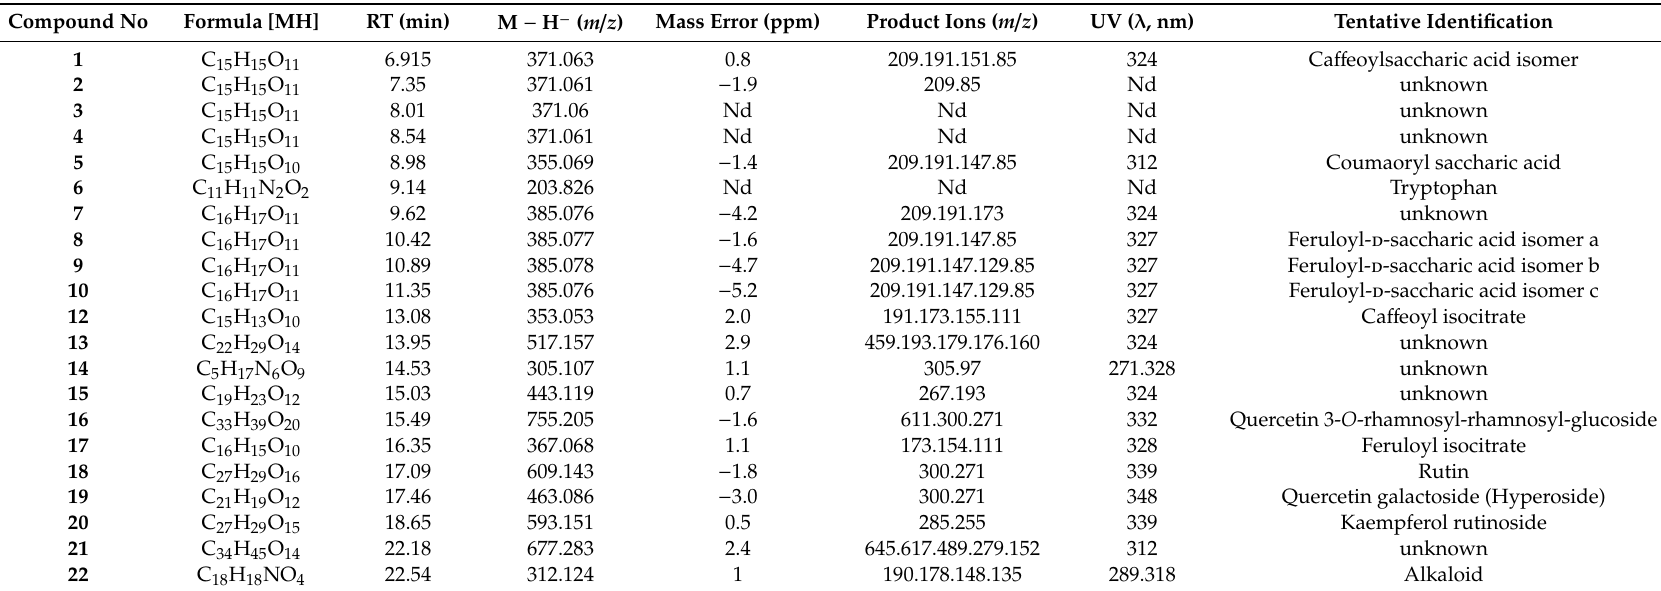
Abbreviations: Nd = not